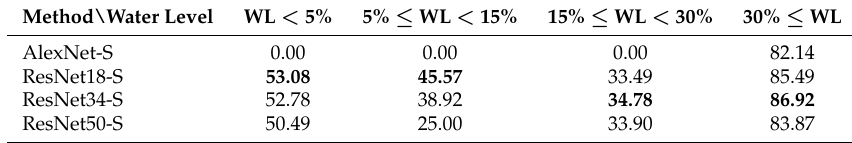
Table A4. Per-class F1 score for the CNNs trained from scratch—Class15 training